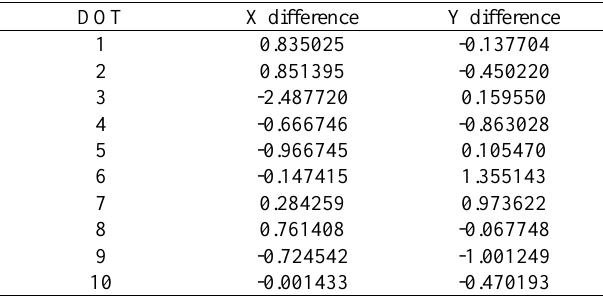
Table 4 The coordinate difference of reflector in image